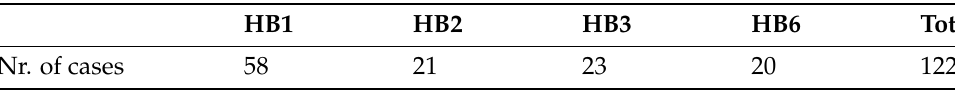
Table 6. Frequencies of adjusted HB